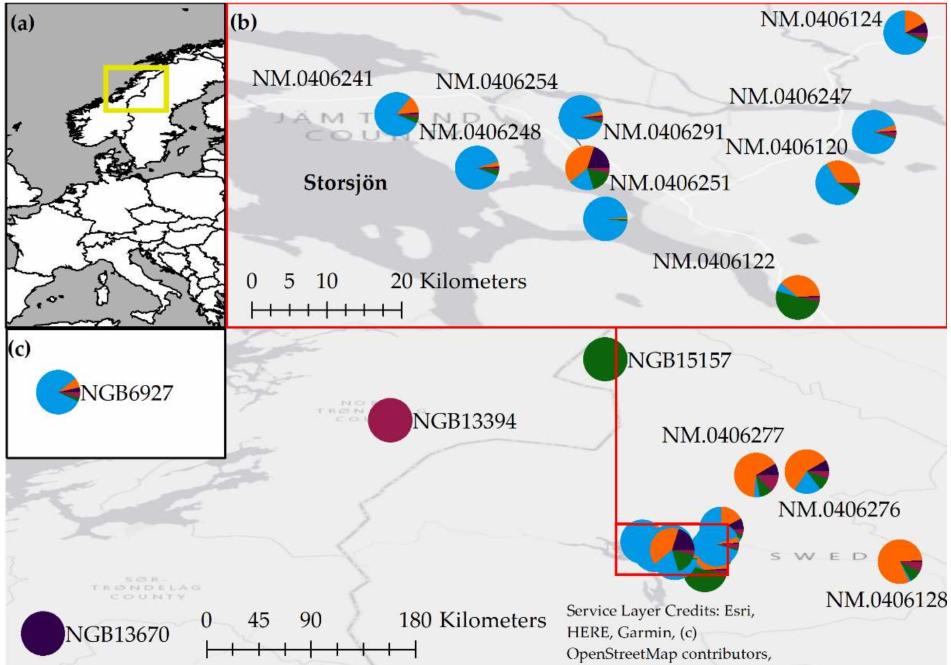
Figure 2. ( a ) Yellow rectangle on inset map of Europe shows extent of map; ( b ) Geographic structuring among accessions plotted on map assuming five clusters. The inset map with red frame shows a higher resolution view of the Storsjön area; ( c ) The extant accession NGB6927, only localized to county level, is displayed in the white square to the left.